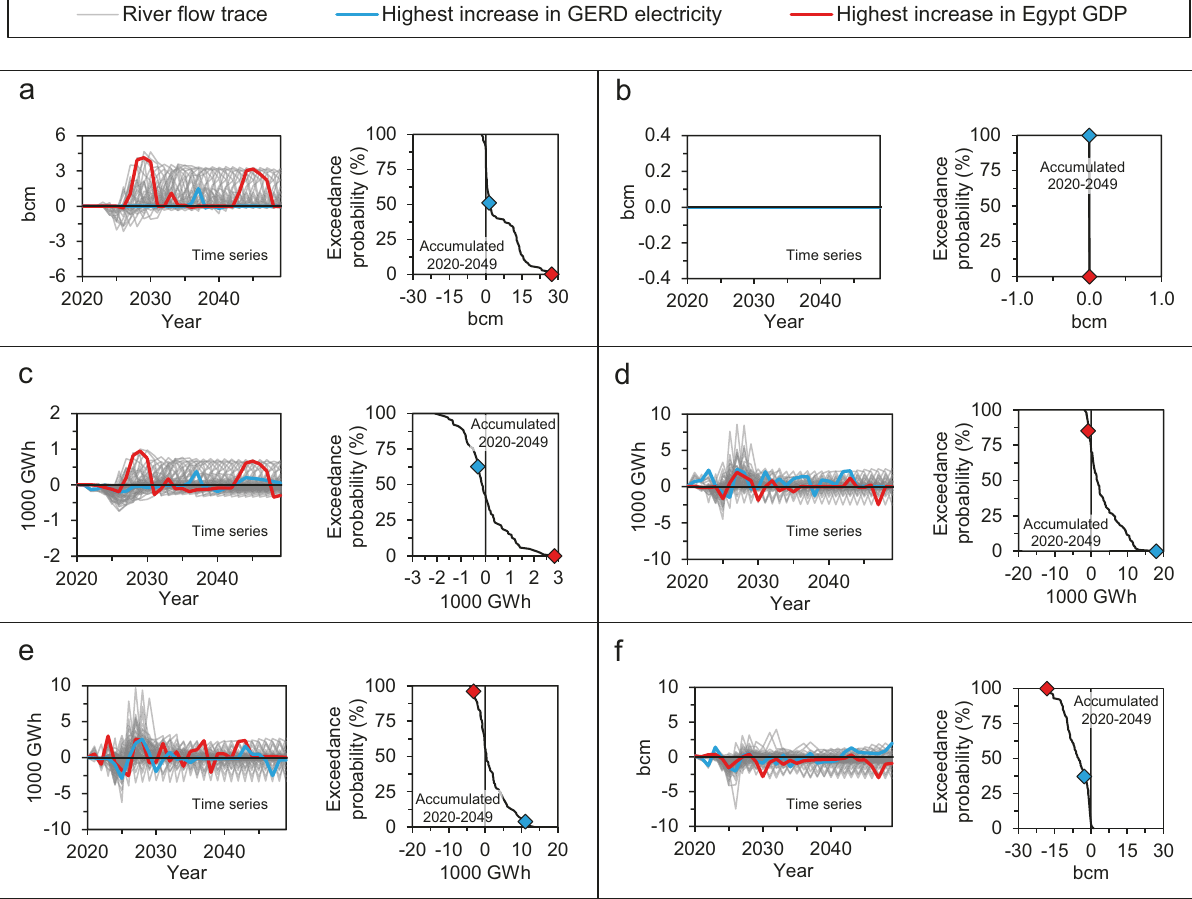
Table 2 Difference in selected water, energy, and economy metrics between the coordinated operation and the Washington draft proposal.